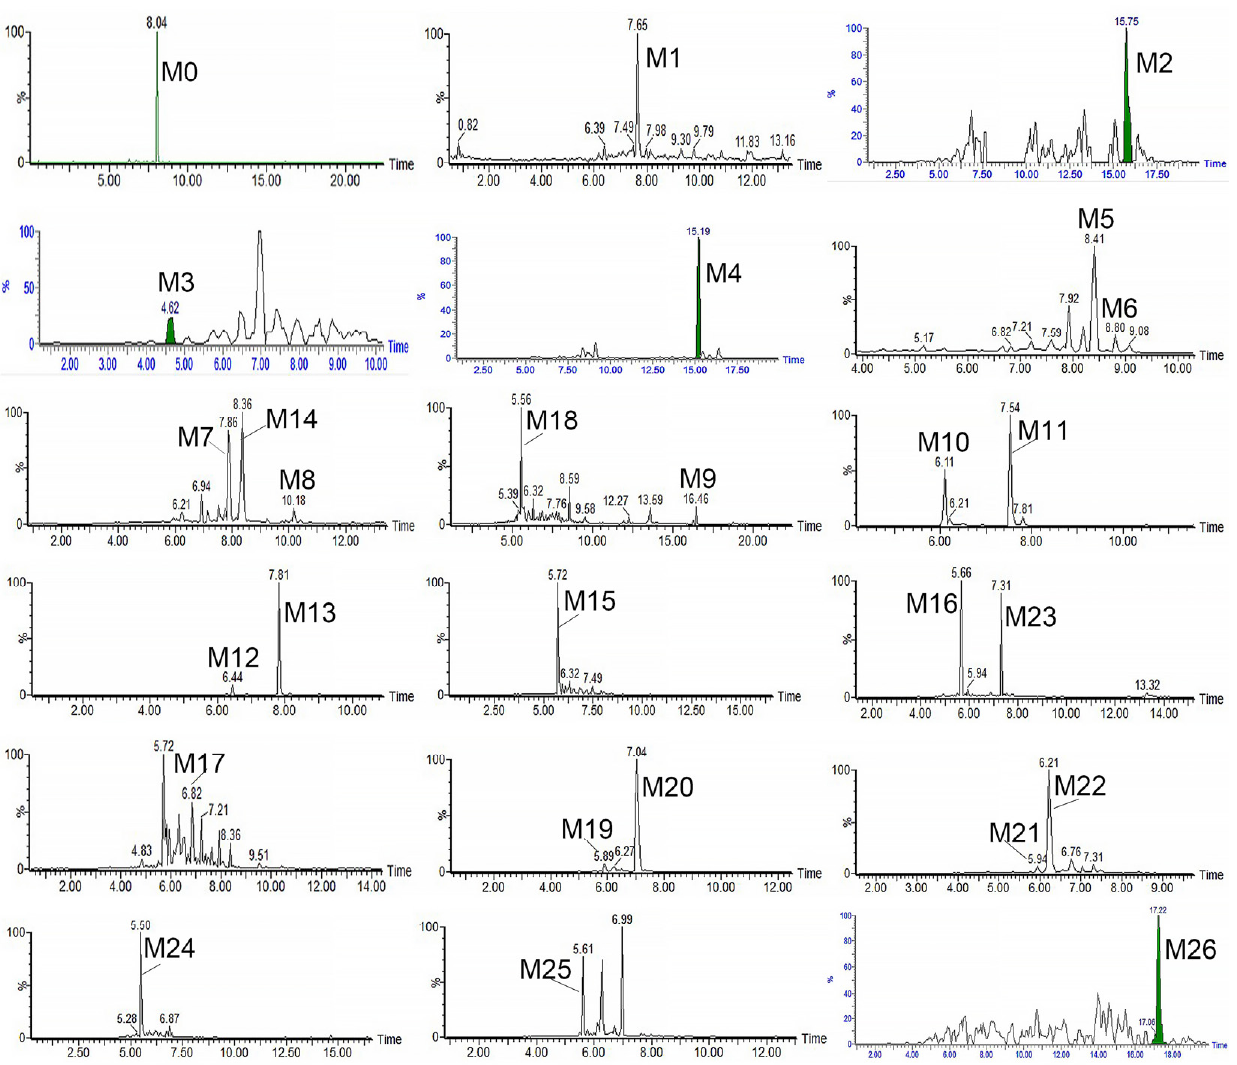
Figure 3. The extracted ion chromatograms of RA and its metabolites. Table 1. The metabolite information of RA.